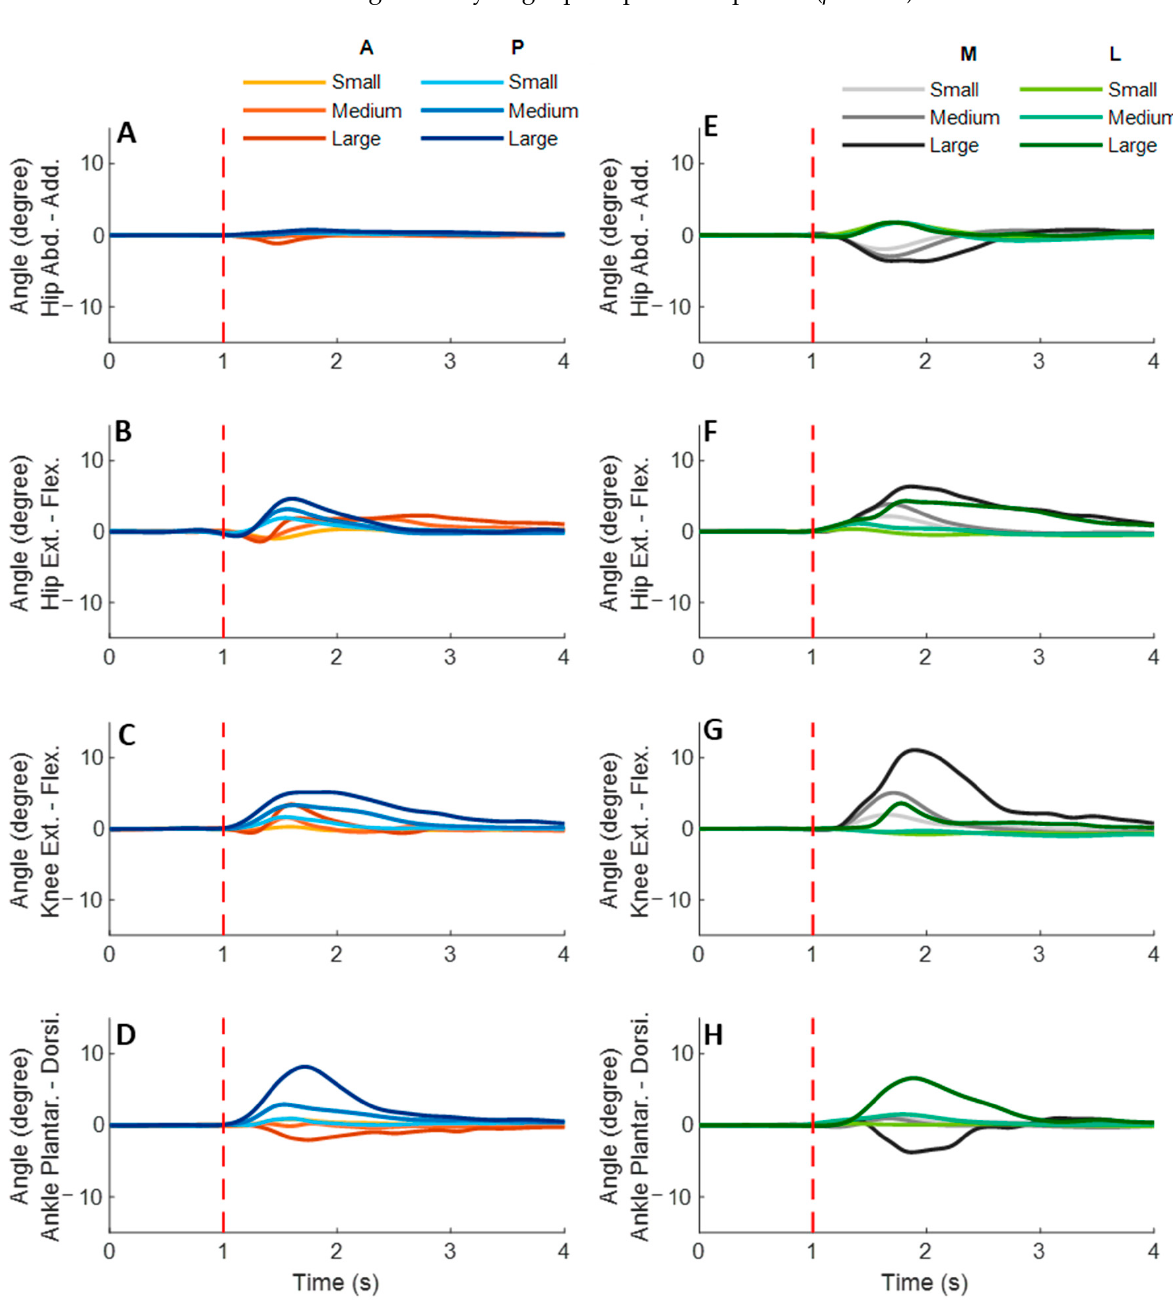
Figure 5. The mean dominant-leg joint angle changes of twelve participants following the un- expected anterior, posterior, medial, and lateral perturbations with three magnitudes ( n = 12). Mean hip adduction-abduction ( A ), hip flexion-extension ( B ), knee flexion-extension ( C ), and ankle dorsiflexion-plantarflexion ( D ) angle changes following anterior and posterior perturbations; Mean hip adduction-abduction ( E ), hip flexion-extension ( F ), knee flexion-extension ( G ), and ankle dorsiflexion-plantarflexion ( H ) angle changes following medial and lateral perturbations. (Note: The red dotted line indicated the start of pulling perturbation. Add. : adduction; Abd. : abduction; Flex. : flexion; Ext. : extension; Dorsi. : dorsiflexion; Plantar. : plantarflexion. A : anterior; P : posterior; M : medial; L : lateral).